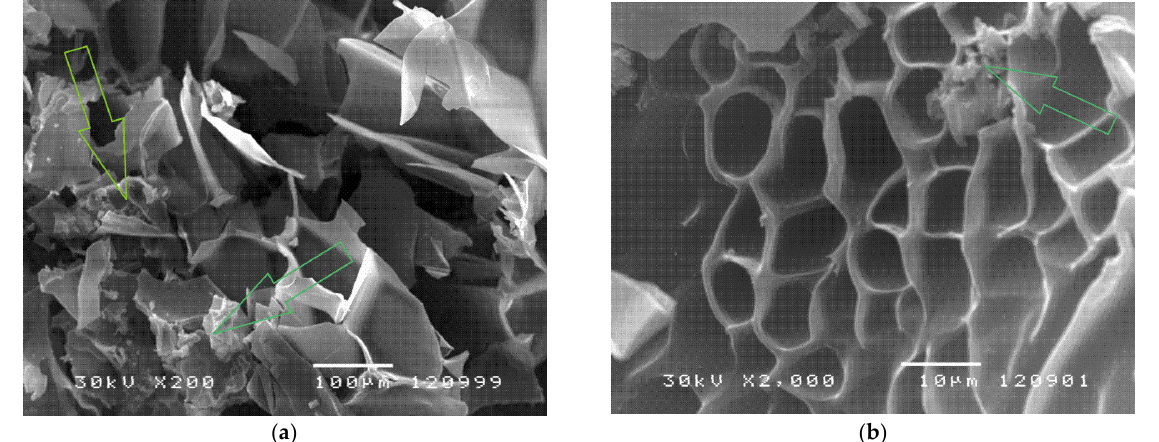
Figure 5. SEM micrographs of poly( N -isopropylacrylamide- co -2-hydroxypropyl methacrylate) with incorporated piroxicam in the equilibrium swollen state at: ( a ) magnification 200×, scale bar 100 μm; ( b ) magnification 2000×, scale bar 10 μm.